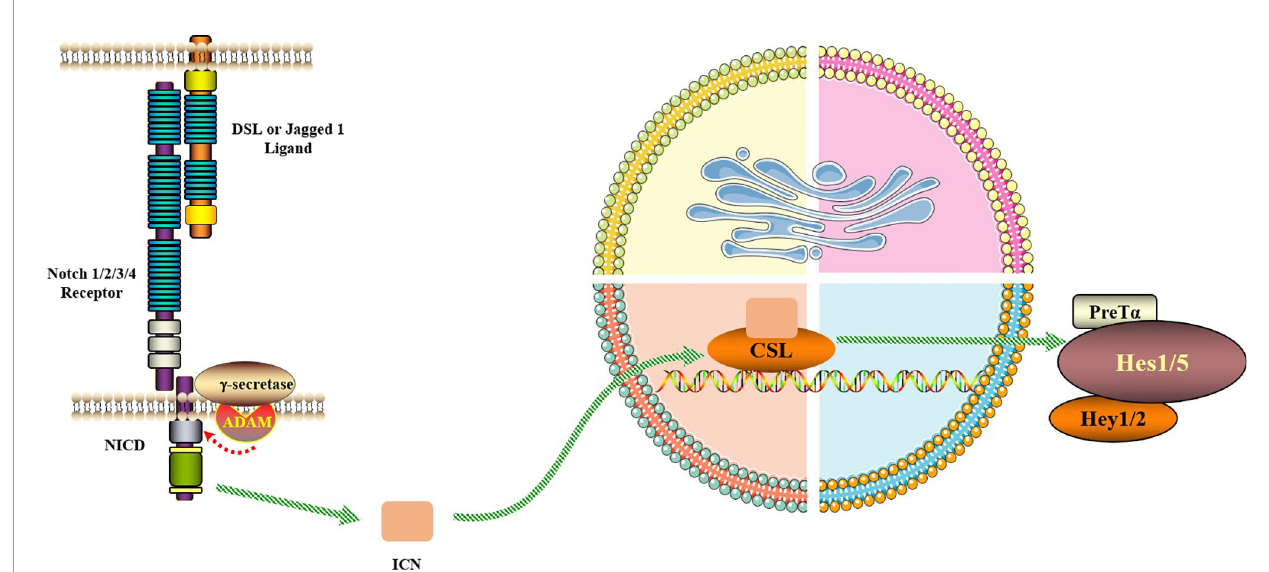
FIGURE 2 | Notch signaling pathway. The Notch signaling pathway consists of Notch, Notch ligand (DSL or Jagged1/2) and CSL (a class of DNA-binding proteins, include RBPJ). Notch signaling is generated by the interaction of Notch ligands of neighboring cells with the receptor, initiating ADAM10-mediated proteolysis of the extracellular domain. After three times of cleavage, Notch protein is released into the cytoplasm from the NICD and enters the nucleus to bind to the transcription factor CSL to form the NICD/CSL transcriptional activation complex, which activates the target genes of the transcriptional inhibitory factor family such as Hes and Hey, and plays a biological role.